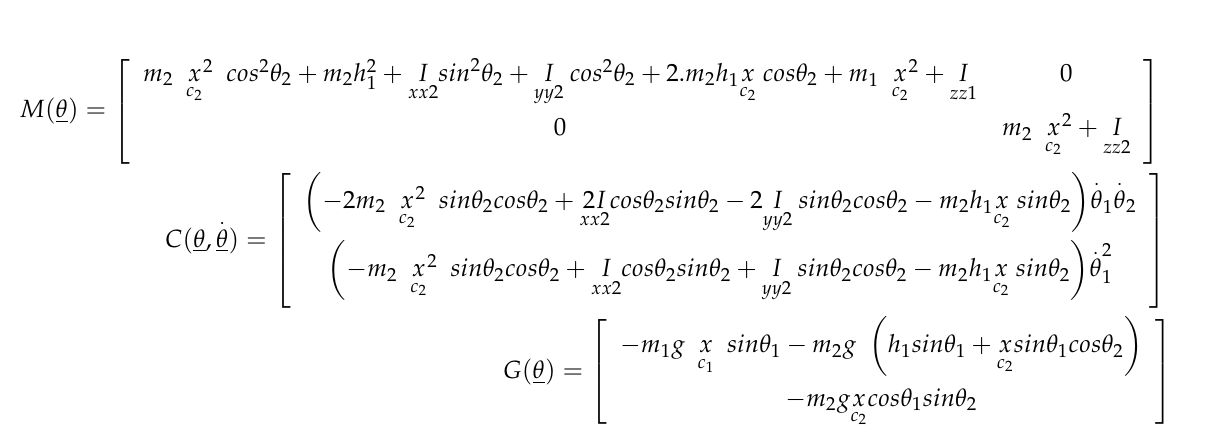
The parameters of the above matrixes are defined in Table A1. The values considered in simulations are presented as well. Table A1. Description of the parameters in Equation (2) and the values considered in the